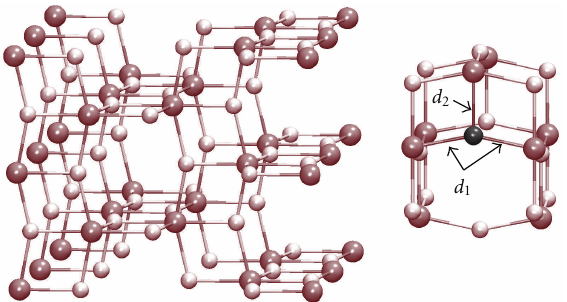
Figure 1: The supercell geometry and the doped position of the anatase TiO 2 model. The big gray ball represents Ti atom; the small light ball represents O atom; the dark ball denotes the dopant.